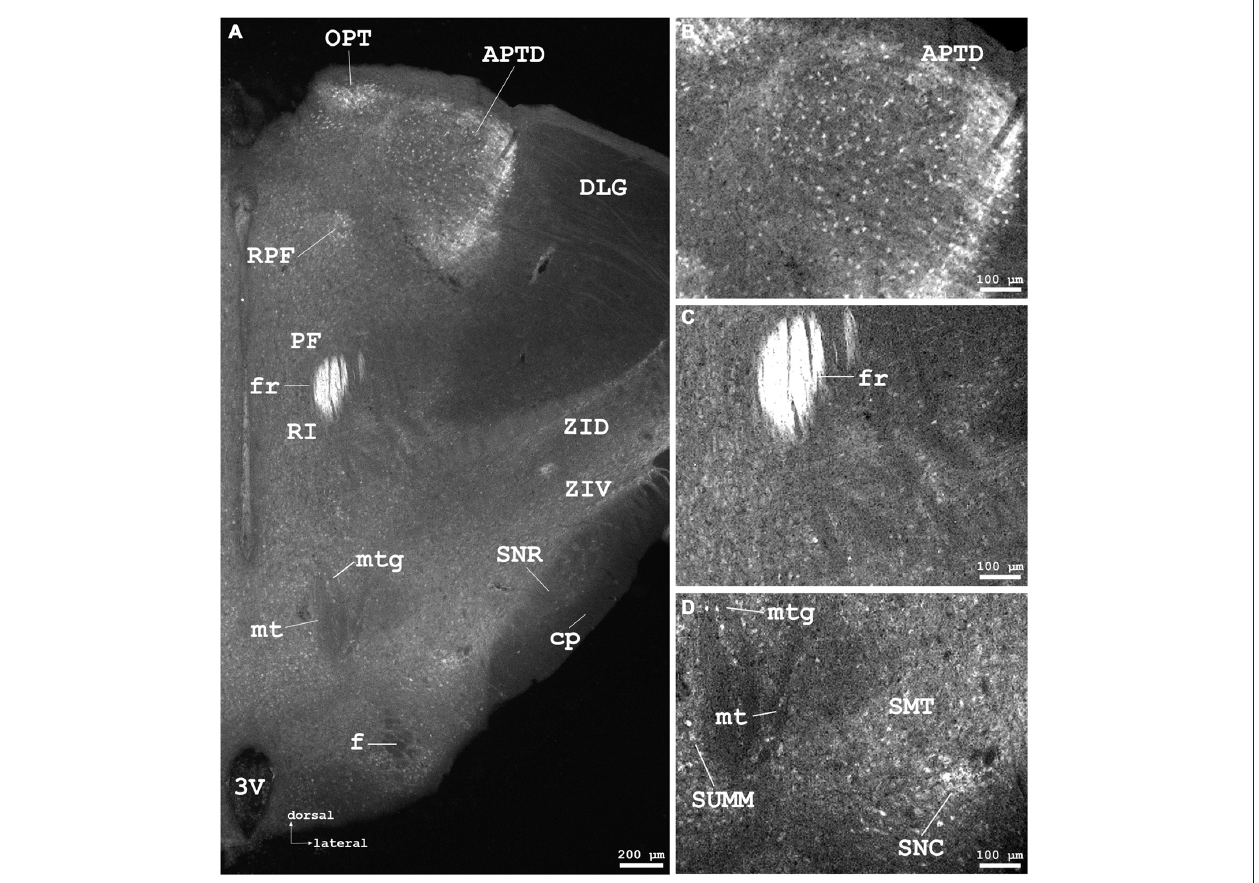
FIGURE 5 | Cygb-immunofluorescence in a frontal section of the mouse brain at the level of approximately interaural +1.3 mm corresponding to Figure 52 of the mouse brain atlas. (A) Low power photomicrograph (MIA) demonstrating labeled neurons in the dorsal part of the anterior pretectal nucleus (APTD), olivary pretectal nucleus (OPT), retroparafascicular nucleus (RPF), dorsal and ventral parts of the zona incerta (ZID, ZIV), and substantia nigra pars compacta (SNC) and pars reticularis (SNR). Note that the mamillothalamic tract (mt), fornix (f), mamillotegmental tract (mtg) and cerebral peduncle (cp) are unstained, while the fasciculus retroflexus exhibits strong Cygb-immunoreactivity. Moderately labeled neurons were present in neighboring regions such as the parafascicular thalamic nucleus (PF) and the rostral interstitial (RI) nucleus of the medial longitudinal fasciculus (MLF). (B) Higher magnification of IR neurons in the APTD. (C) IR fibers in high density are seen in the fasciculus retroflexus (fr). (D) Higher magnification showing the mamillothalamic (mt) and mamillotegmental (mtg) tracts, and stained neurons of the SNC. Abbreviations: 3V, third ventricle; SMT, submamillothalamic nucleus; SuMM, submamillary nucleus, medial